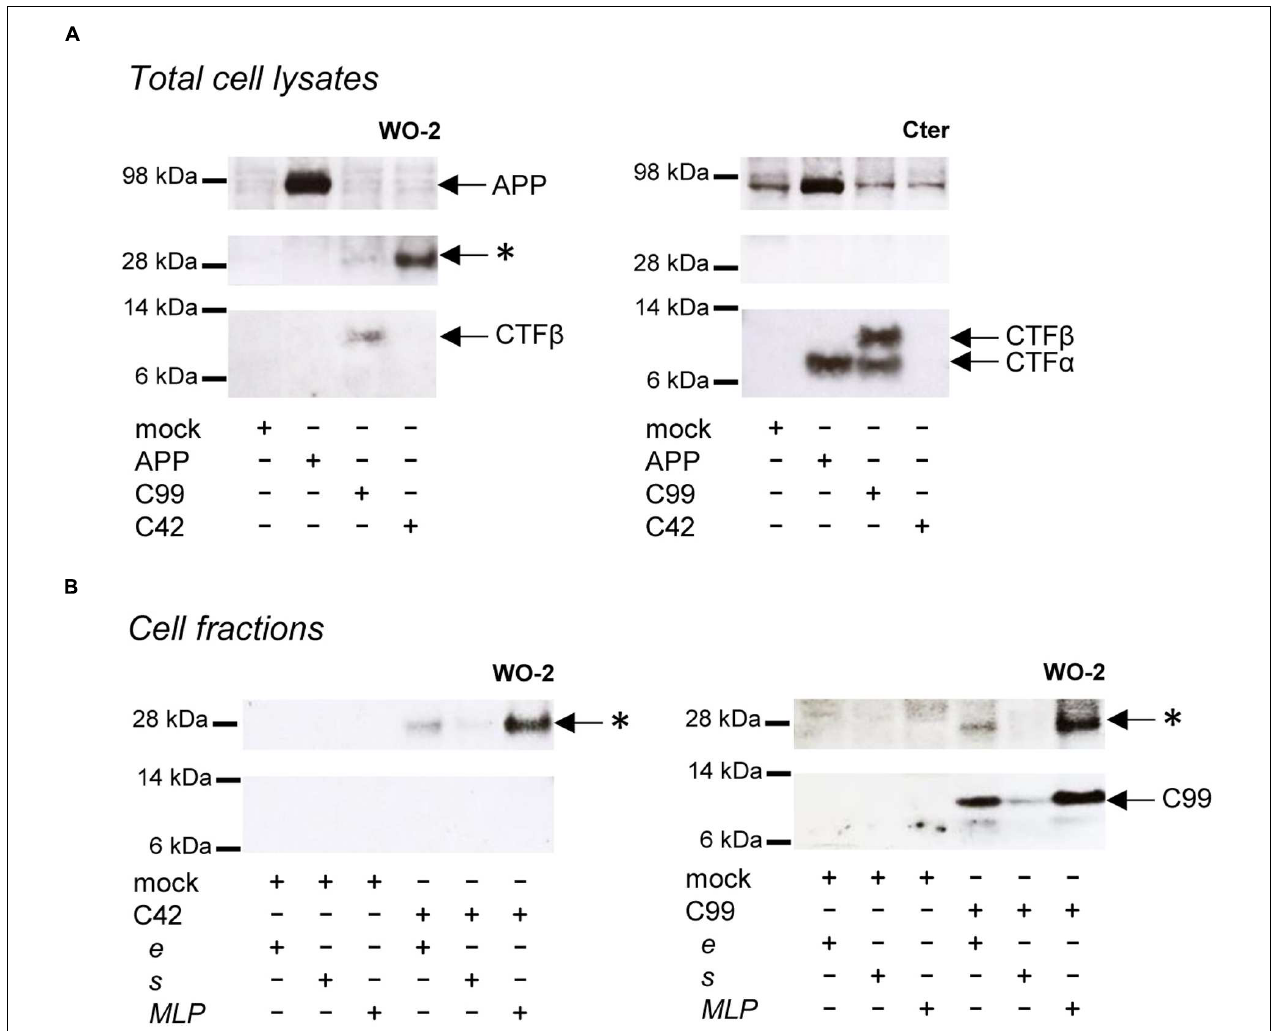
FIGURE 2 | Detection of oligomeric bands in cells expressing C99 and C42. (A) Expression of APP, C99 and C42 in CHO cells analyzed in total cell lysates by Western blotting with the W0-2 antibody (left panel) and the APP C-terminal antibody (right panel). The presence of APP, β CTF (C99) and α CTF are indicated by arrows. The star ( ∗ ) indicates the presence of an unexpected band at ∼ 30 kDa. (B) Cell fractions from C42- (left panel) and C99- (right panel) transfected cells were analyzed by Western blotting with the W0-2 antibody. Total cell lysates (e) were fractionated into soluble (s) and membrane-enriched vesicular fractions (MLP). The presence of the higher molecular weight band ( ∗ ) is indicated by